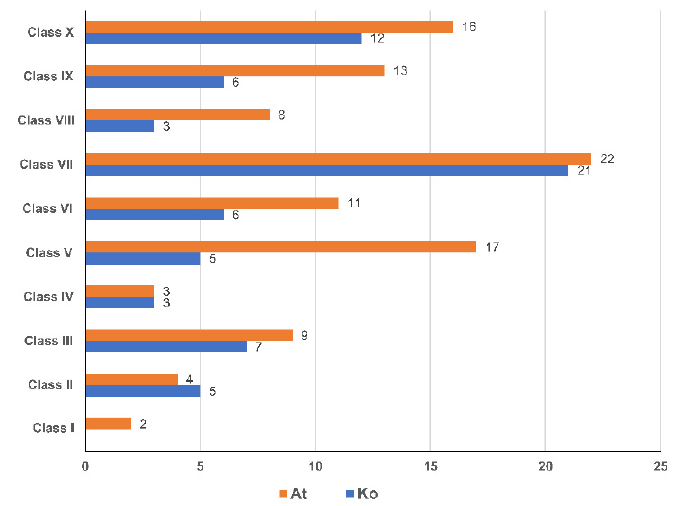
Figure 3. Classification comparison between K. obovata ( Ko ) and A. thaliana ( At ) NAC proteins.